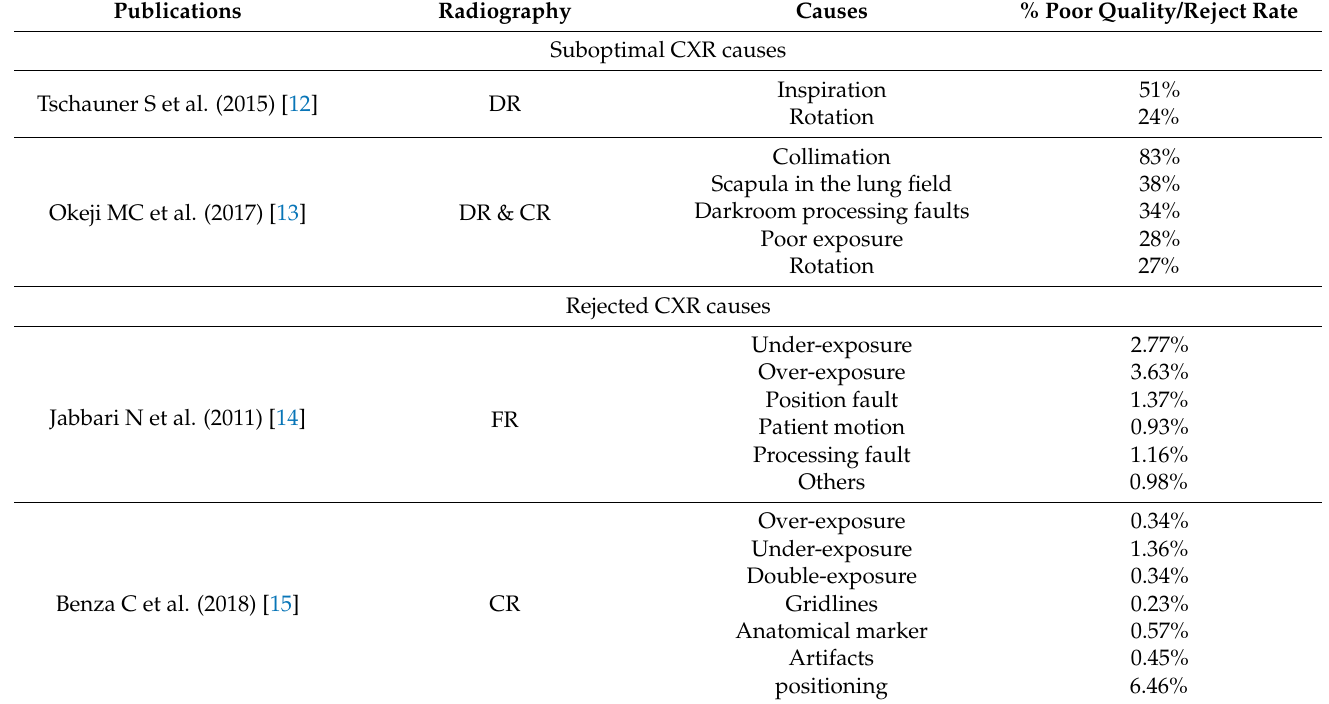
Table 1. Summary of prior publications on various causes of suboptimal CXRs. (Key: DR—digital